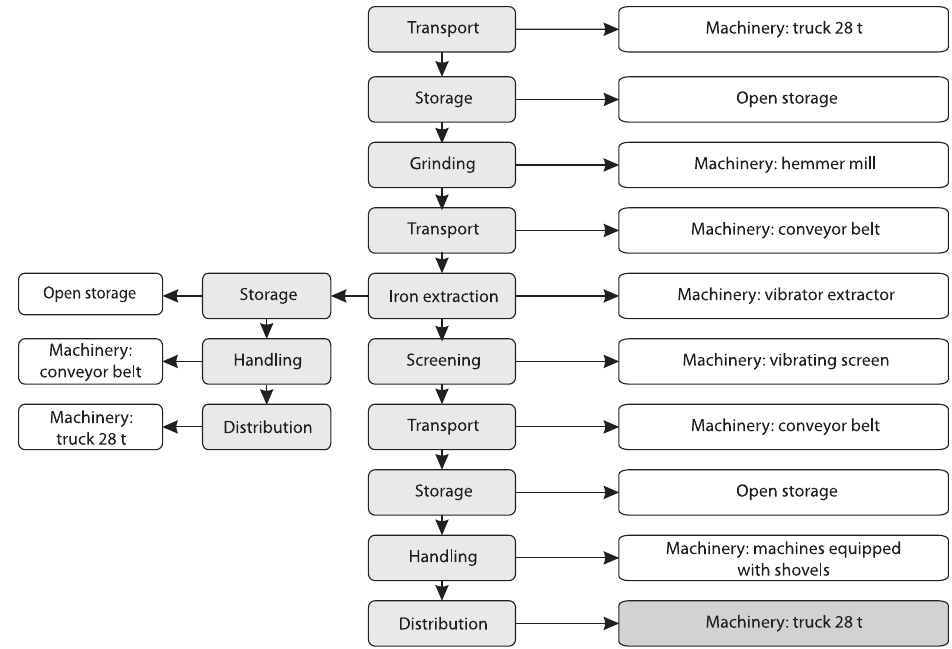
Fig. 2. Scheme of the production process of aggregate 0/30 mm from inert